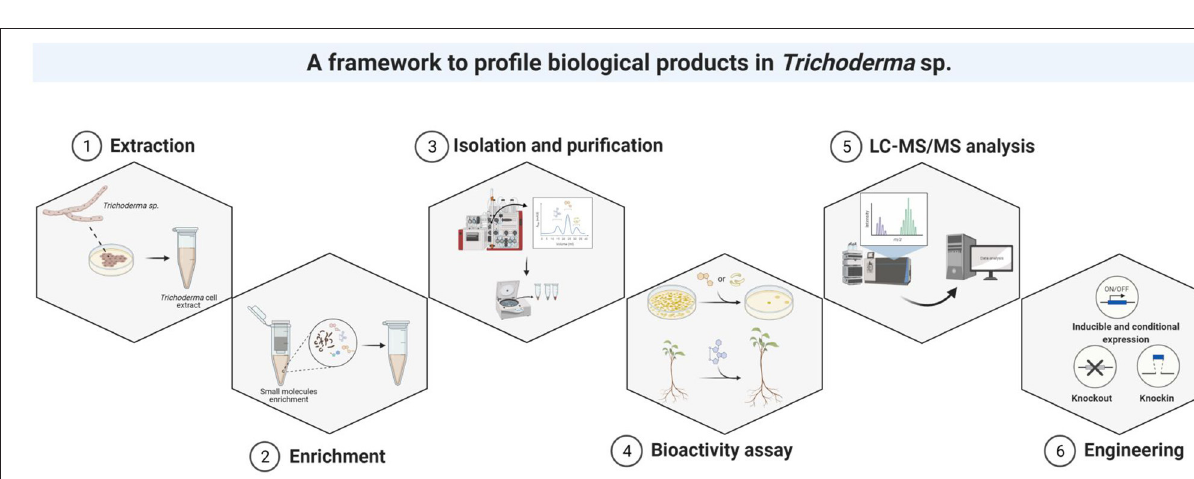
Frontiers in Fungal Biology |